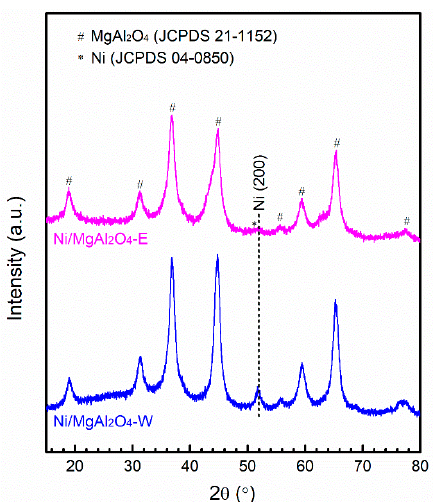
2 O 4 -W and Ni/MgAl 2 O 4 -E